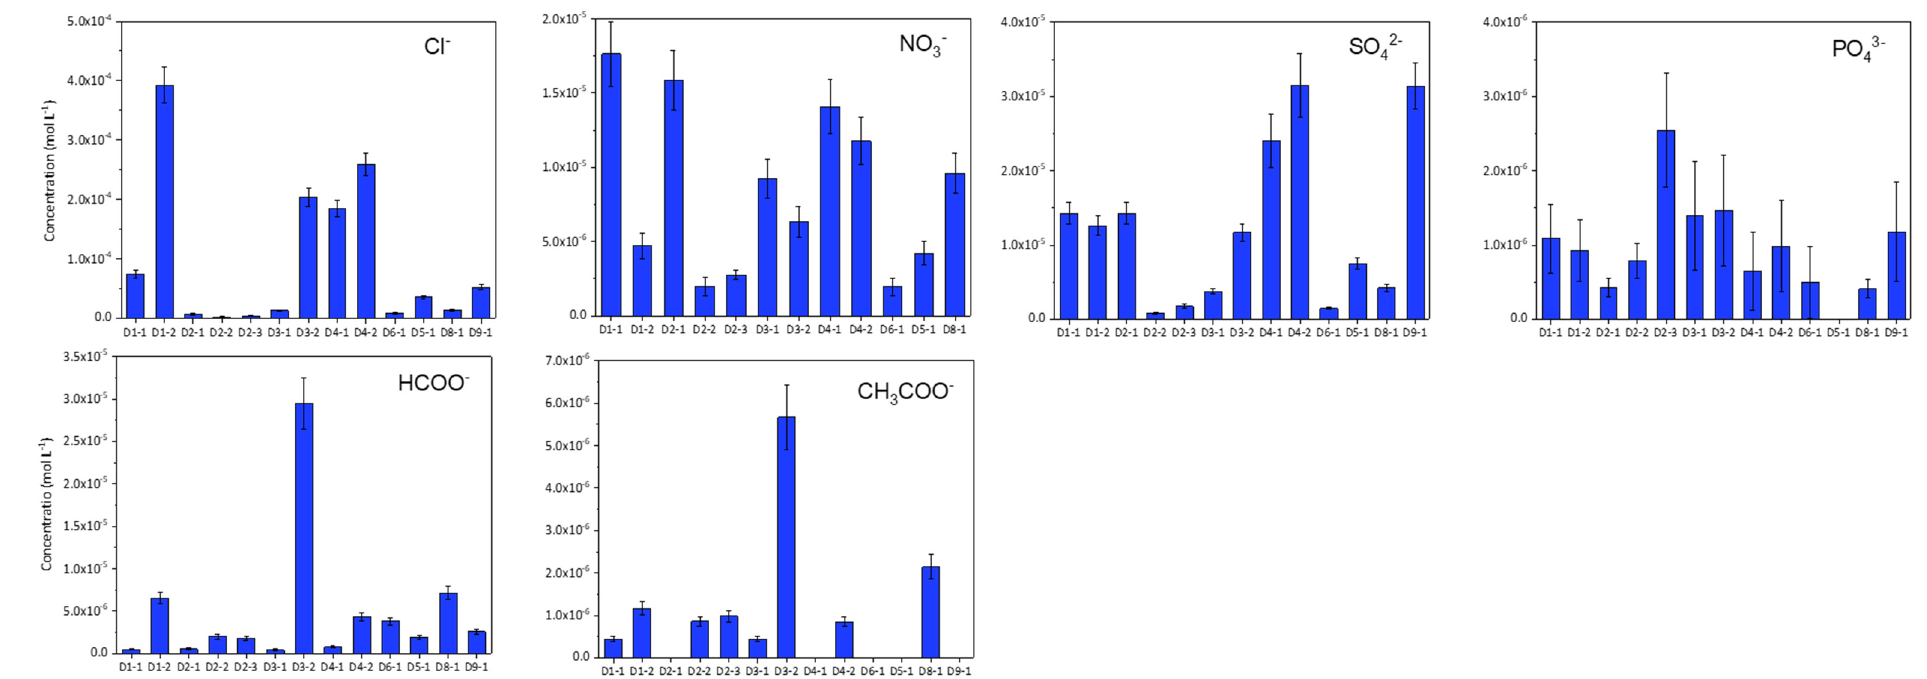
Figure 3. Concentrations and corresponding standard deviations (mol L − 1 ) of the anions of the atmospheric deposition samples. The horizontal axis labels represent the sample codes (see Table 1).